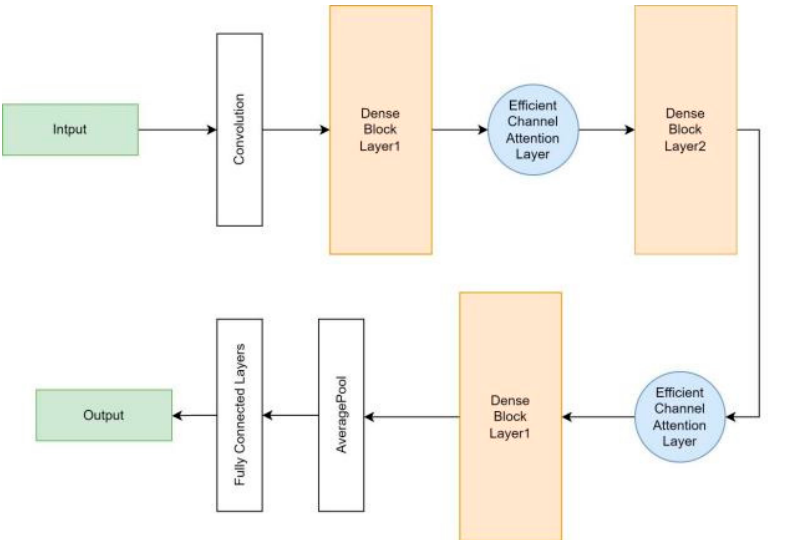
Figure 8. Schematic illustration of the overall architecture of the DenseNet (ECAD) network based on the attention mechanism.